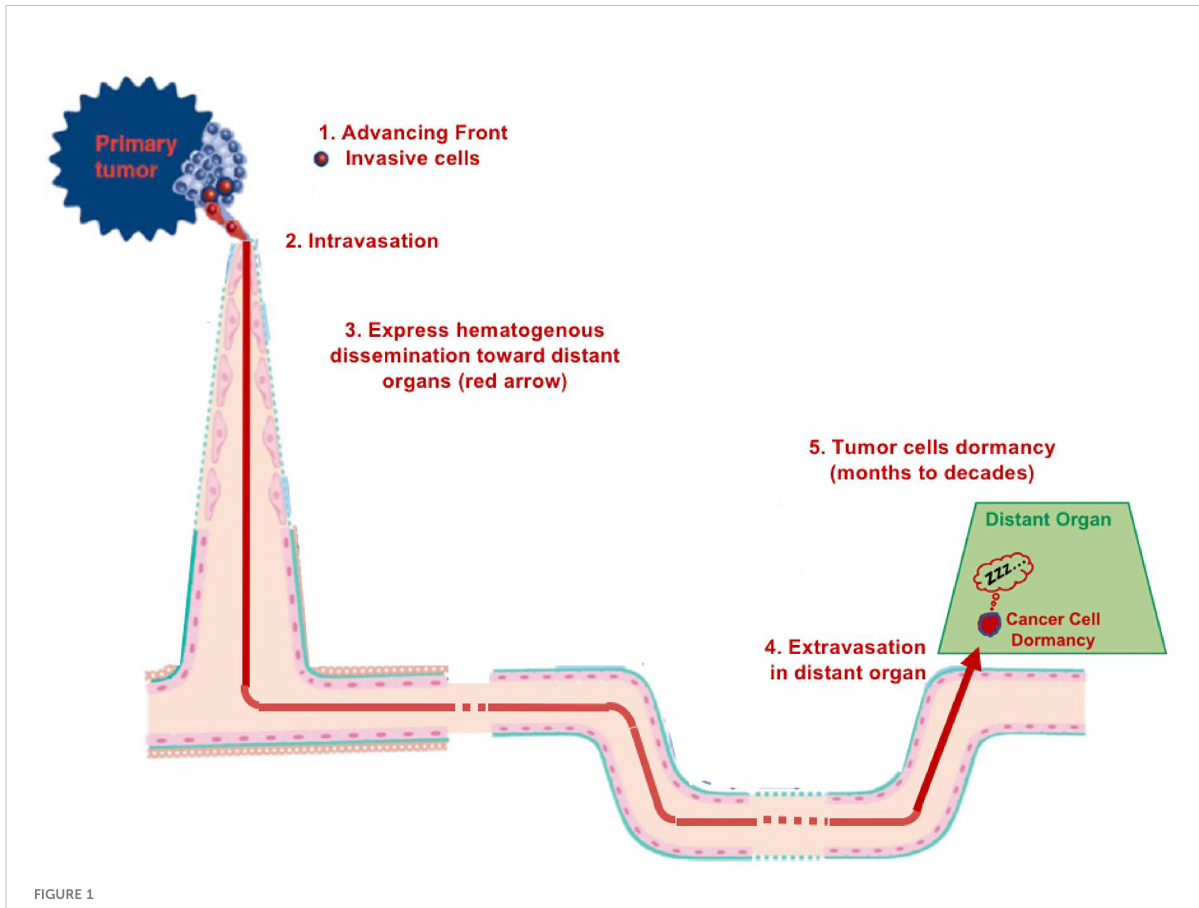
FIGURE 1 Diagram of hematogenous